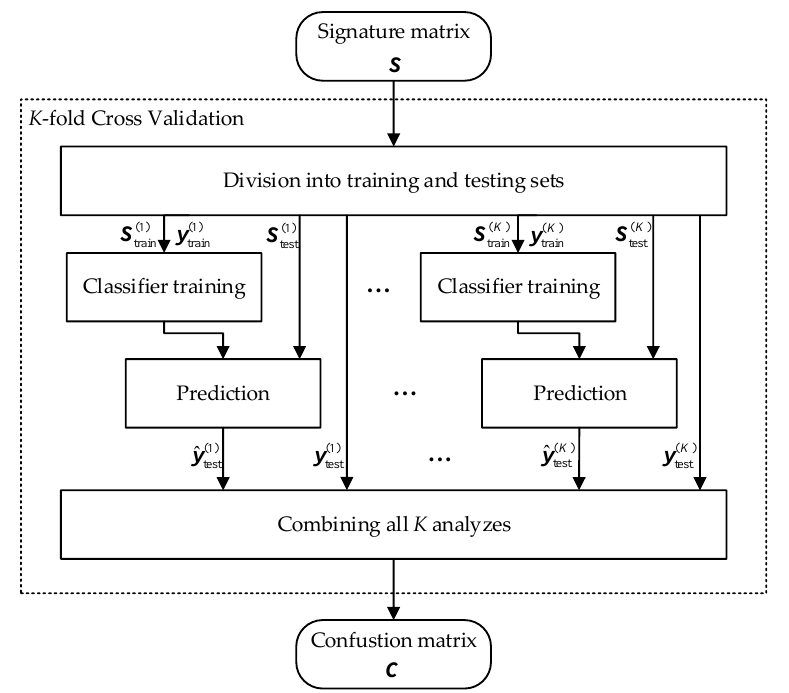
Figure 15. Block diagram of the signature quality assessment method.